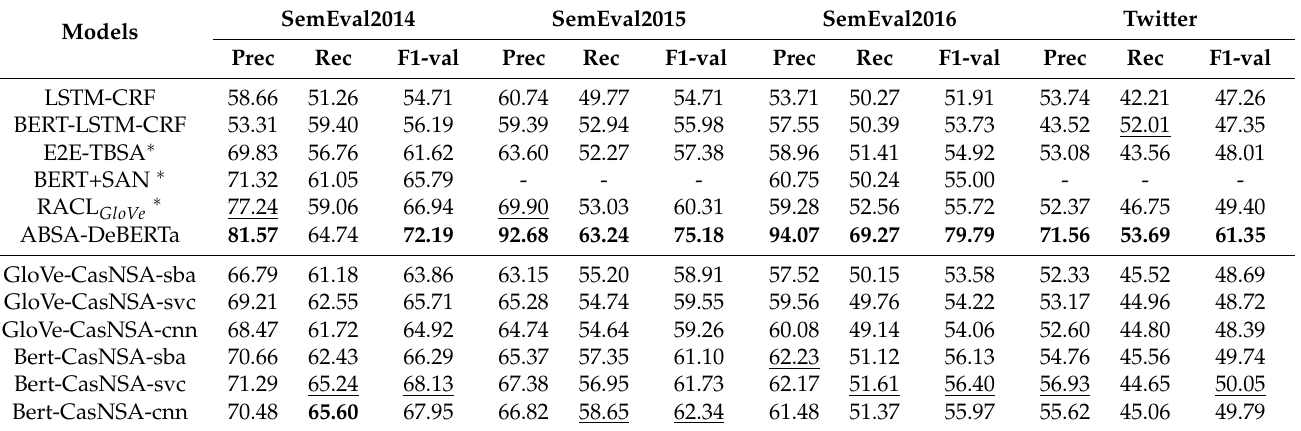
Table 4. Comparison results of different methods on the development sets for the fine-grained sentiment analysis task. The first group includes the pipeline competitors, the second group contains our CasNSA variants. The models that have marked * denote that the results are quoted directly from their original published literature rather than our reproduction results. Bold marks the best scores among all models, and the second best scores are